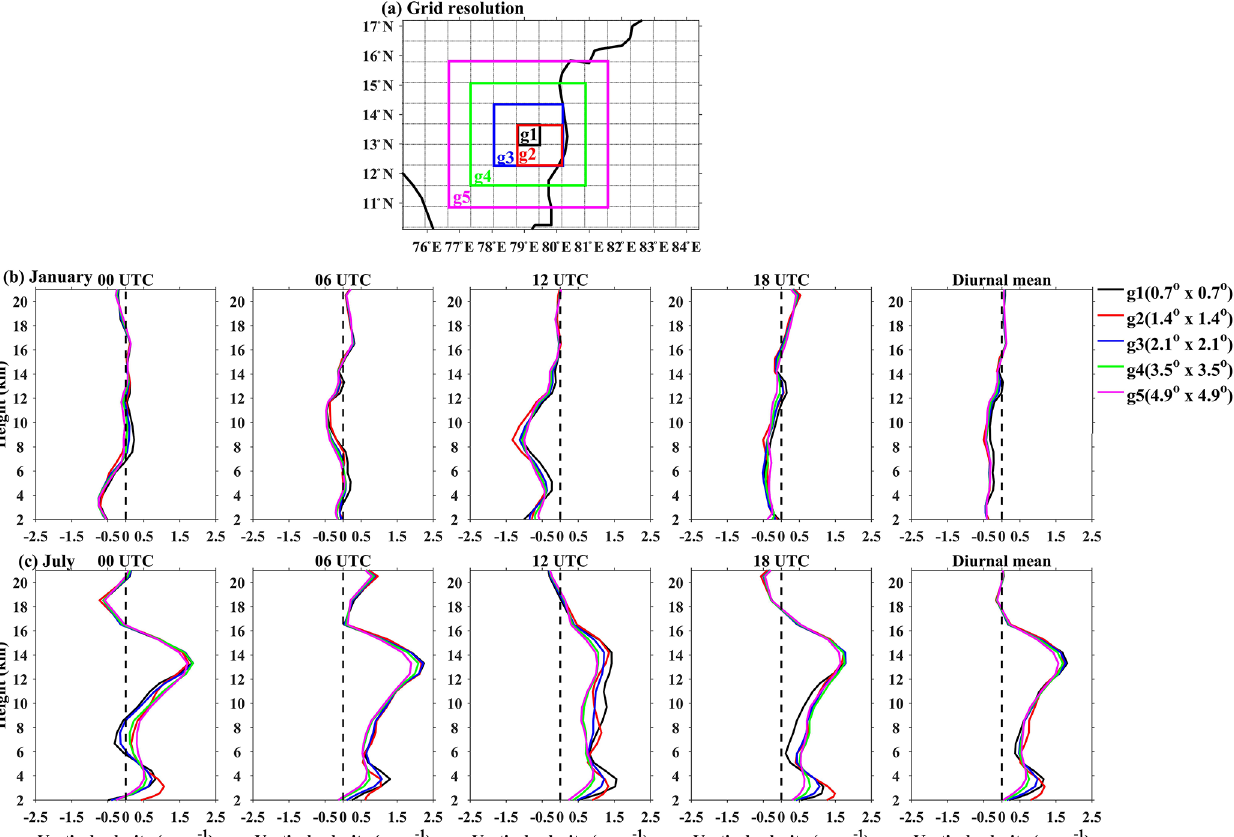
Figure 12. (a) Map for spatial averaging (grid resolution) and height profiles of w for different spatial averaging at 00:00, 06:00, 12:00 and 18:00UTC, respectively, for ERAi reanalysis during